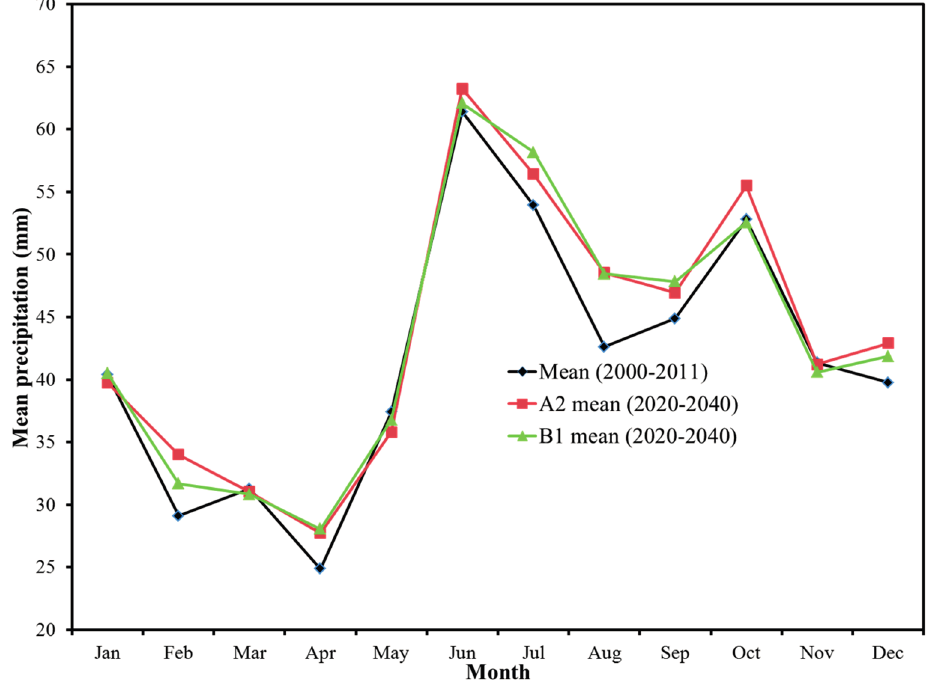
Figure 6. Comparison of projected mean monthly precipitations under the A2 and B1 scenarios from 2020 to 2040 with respect to the mean monthly precipitations of